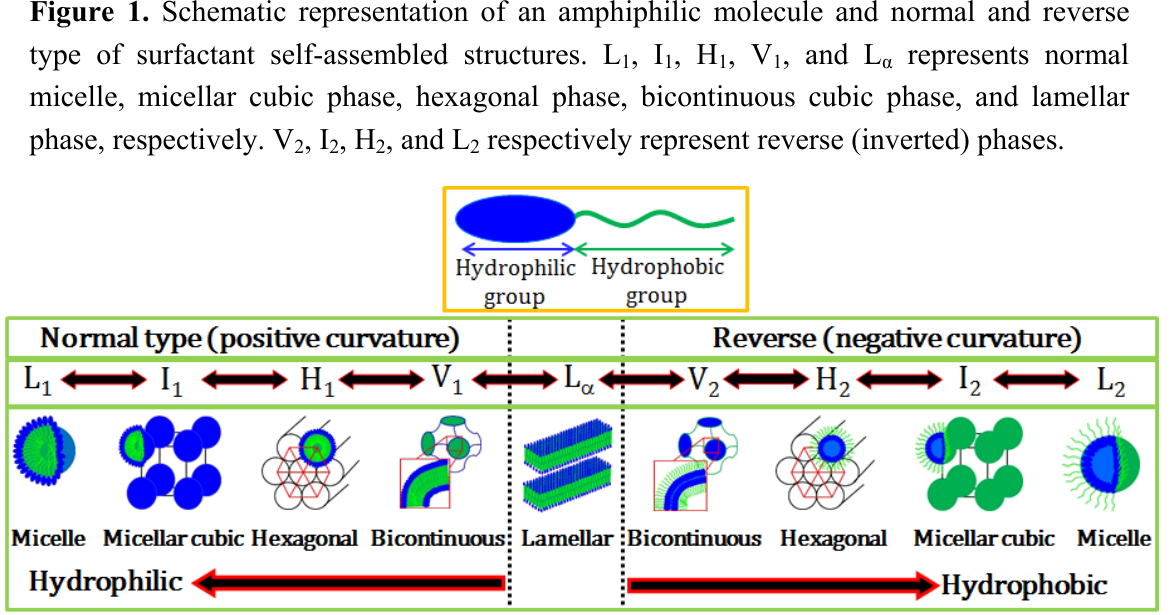
Figure 1. Schematic representation of an amphiphilic molecule and normal and reverse type of surfactant self-assembled structures. L micelle, micellar cubic phase, hexagonal phase, bicontinuous cubic phase, and lamellar phase, respectively. V